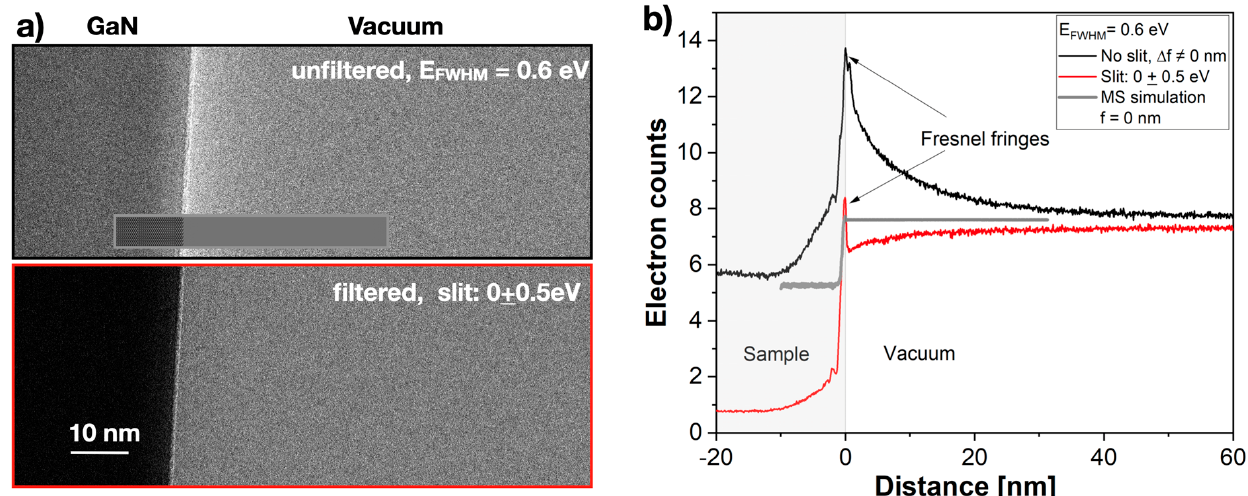
Figure 4. Intensity change by filtering the electron beam. The incident electron distribution was not subtracted. ( a ) Top: an as-recorded image intensity at the GaN/vacuum interface without energy filtering, and an MS simulation of an amplitude image inserted. Bottom: image intensity with an energy-filtered electron beam. ( b ) Averaged intensity profiles perpendicular to the interface. Fresnel fringes occurred if the defocus ∆ f deviated from zero, and were suppressed in amplitude images, as shown by the MS simulation.